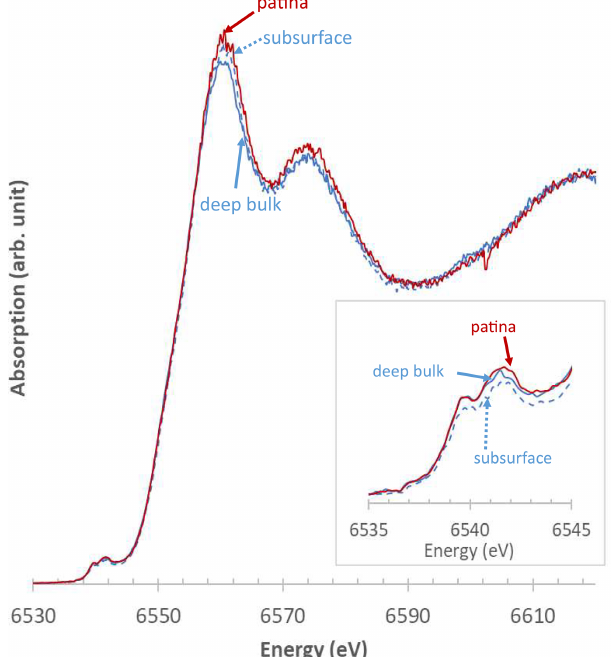
Figure 9. Representative XANES spectra obtained at the Mn K- edge from Mn-rich zones of L1. Solid blue line: bulk; dashed blue line: subsurface; solid red line: patina. Inset: zoom-in on the pre- edge region.